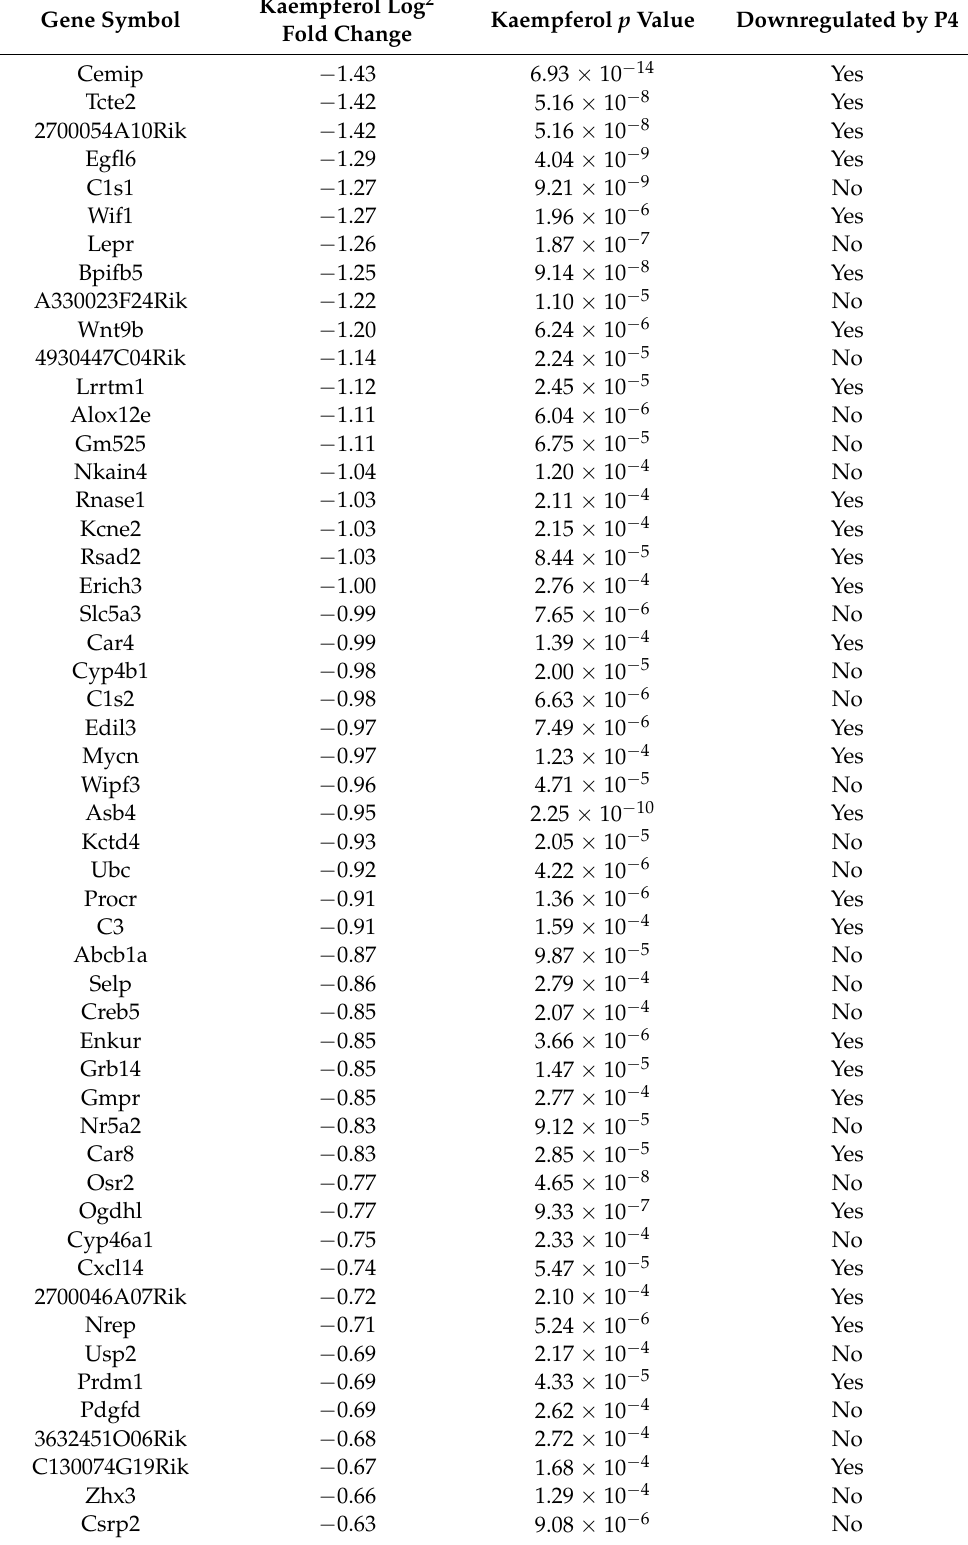
Table 2. Transcripts significantly downregulated by kaempferol treatment when compared with vehicle-treated